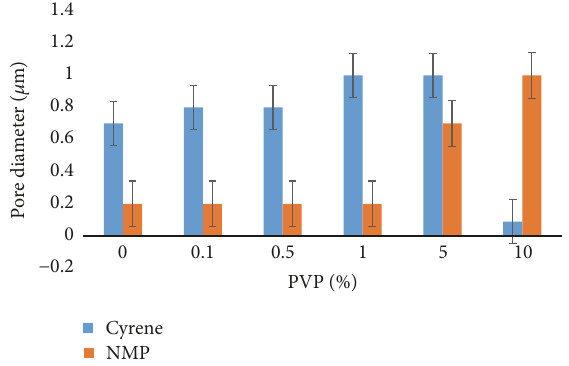
Figure 6: Overall pore diameters ( 𝜇 m) of PES/C (blue) and PES/N